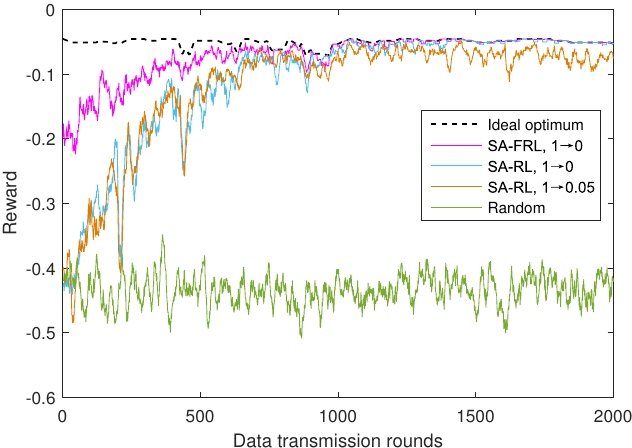
Figure 9. Performance convergence of reward.